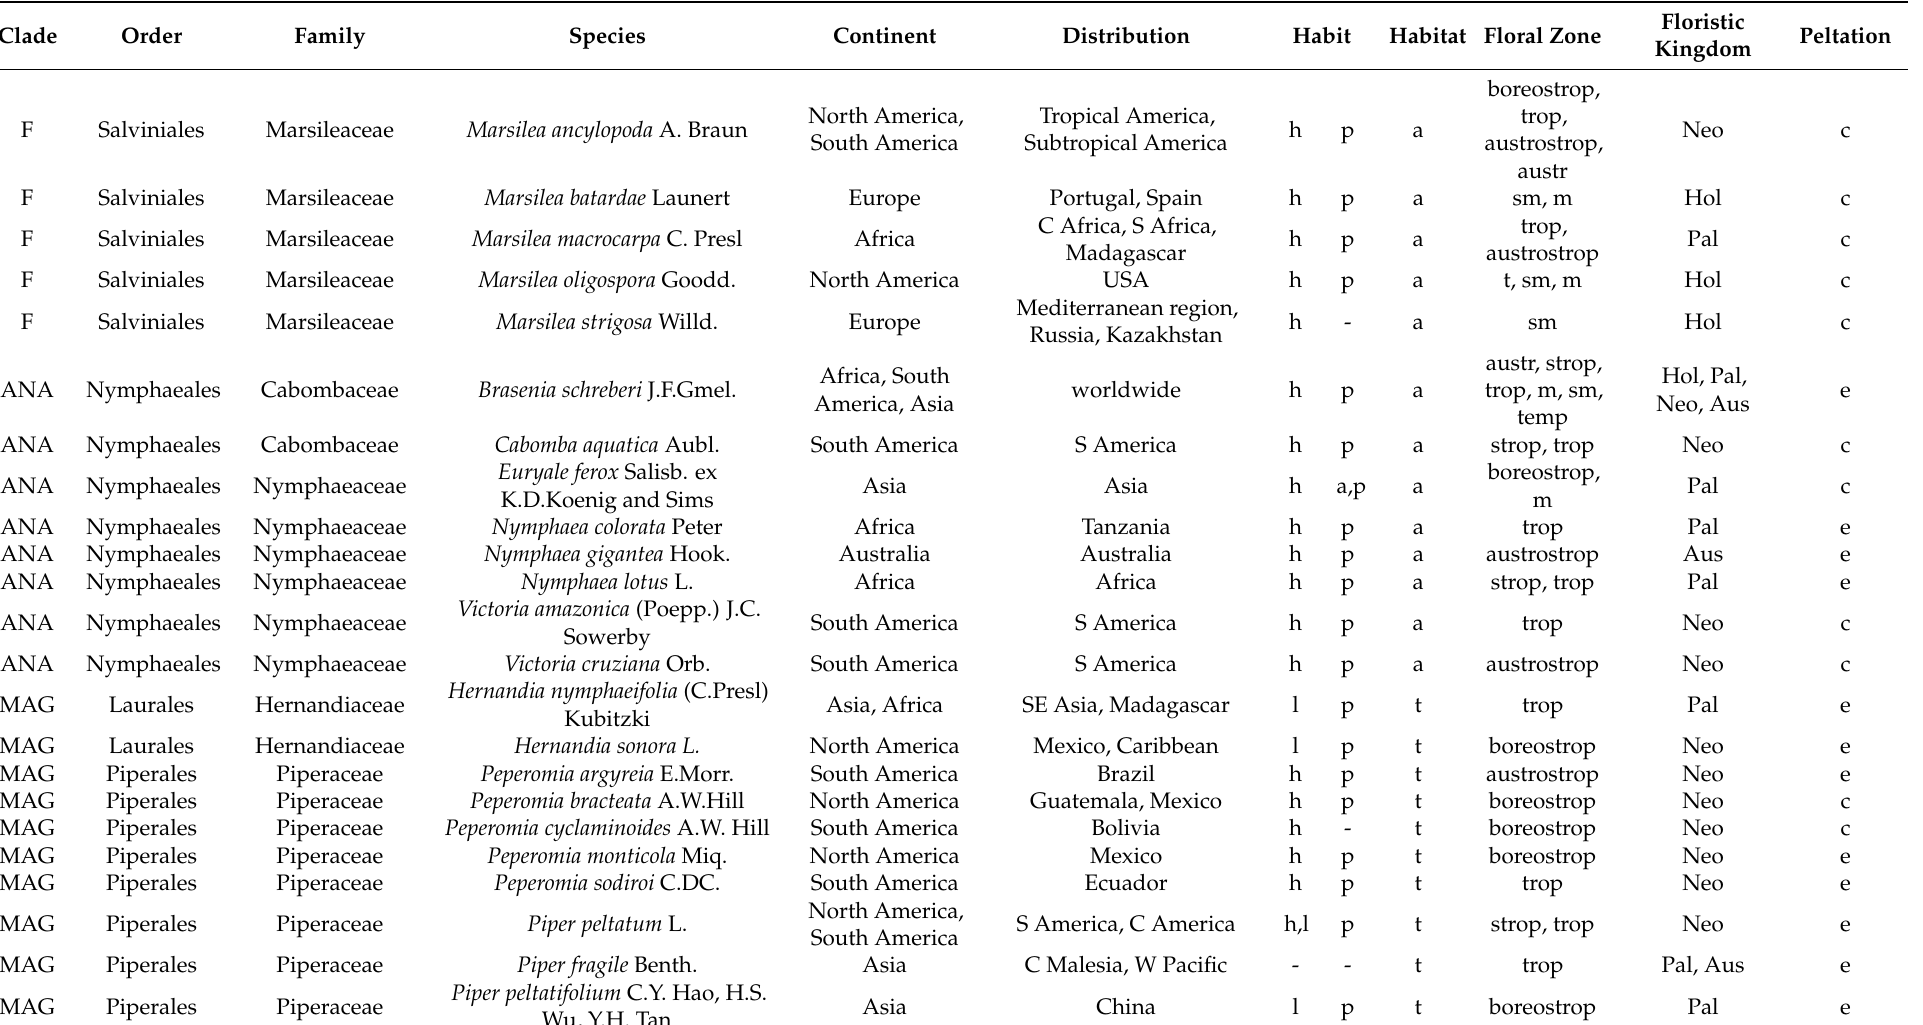
Table 1. List of selected peltate species among vascular